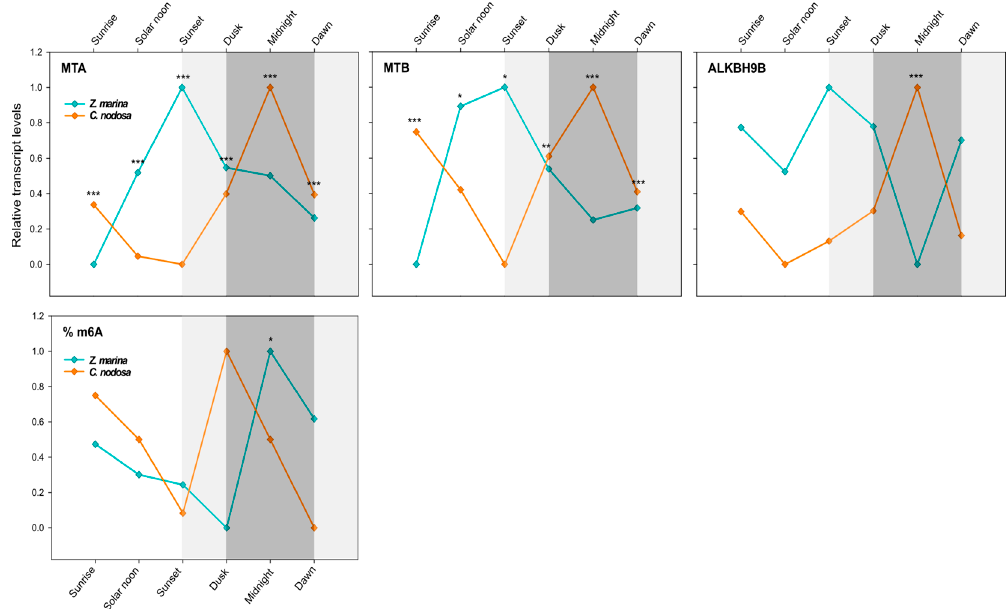
Figure 4. Daily transcript levels (as normalised − ∆ CT data) of writer (MTA and MTB) and eraser (ALKBH9B) genes and % of global m 6 A (normalised data) in Z. marina and C. nodosa (interspecific analysis) at Ria Formosa lagoon (Faro, Portugal). Asterisks represent significant differences between species at the specific time points, as resulting from SNK post-hoc tests following a two-way ANOVA. Light and dark grey boxes highlight the twilight and night times, respectively. * p < 0.05; ** p < 0.01; *** p < 0.001. Table 5. Results of two-way ANOVAs conducted on the global N 6 -methyl-adenosine (m 6 A) level for inter- ( C. nodosa vs. Z. marina ) and intraspecific ( Z. marina at different latitudes) comparisons. p < 0.05 are in bold. Two-Way ANOVAs Effect df Interspecific Analysis Effect df Intraspecific Analysis MS F p MS F p m 6 A m 6 A Species (Sp) 1 0.001 17.763 0.143 La × Ti Error 23 0.000 Error 16 0.133